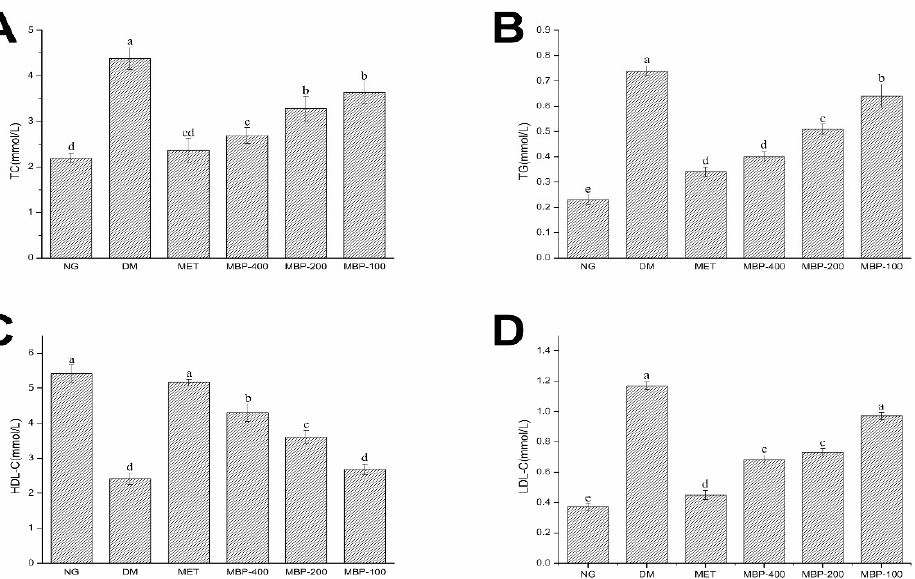
Figure 2. Serum levels of total cholesterol (TC) ( A ), triglycerides (TG) ( B ), high-density lipoproteins (HDL-C ) ( C ) and low-density lipoproteins (LDL-C) ( D ) in rats. Different letters are significantly different at p < 0.05.